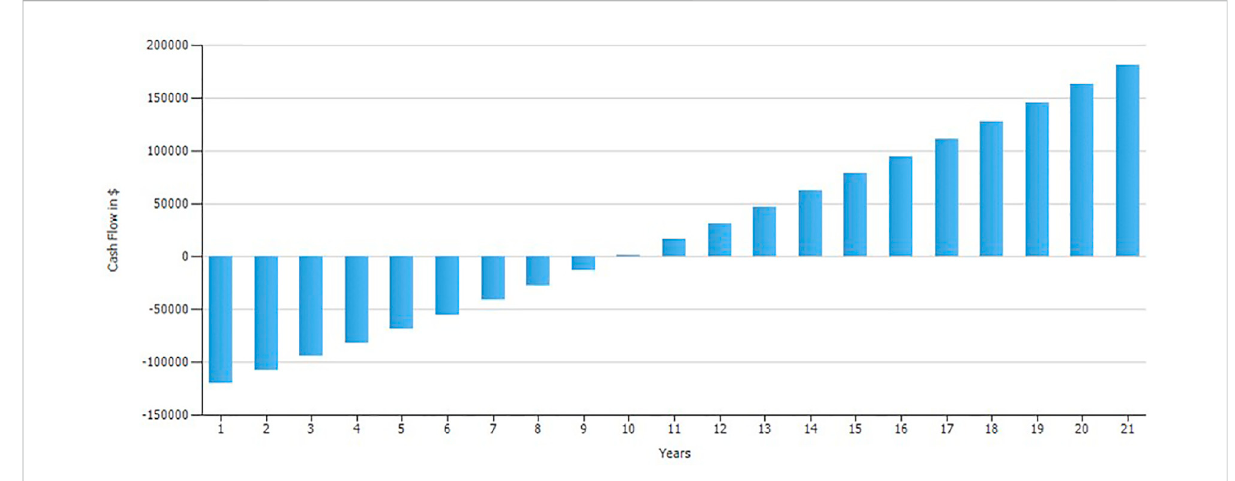
FIGURE 5 Accrued cash fl ow (cash